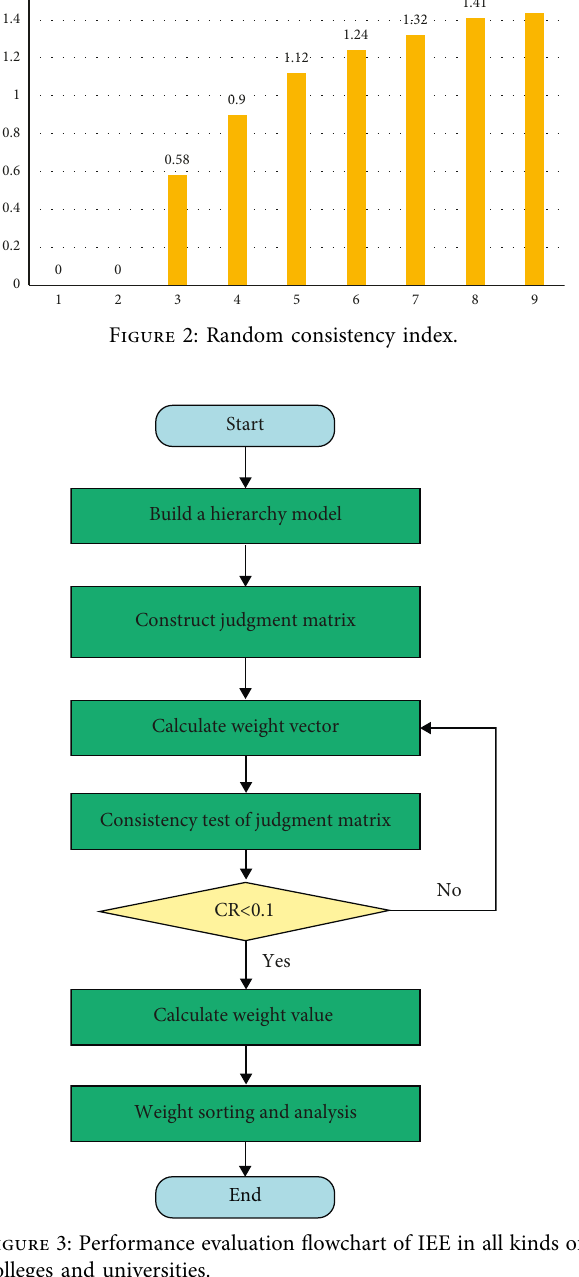
Table 4: Weight of teaching environment in second-level